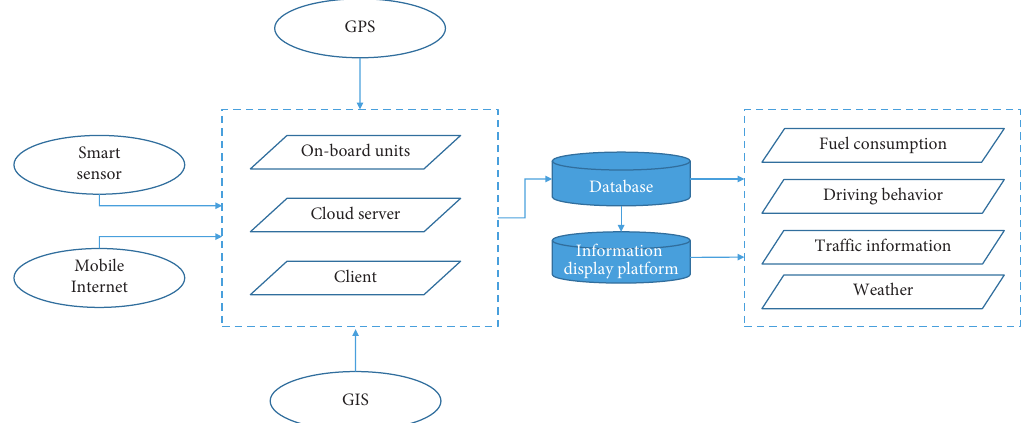
Figure 1: The schematic of the advanced on-board fleet management